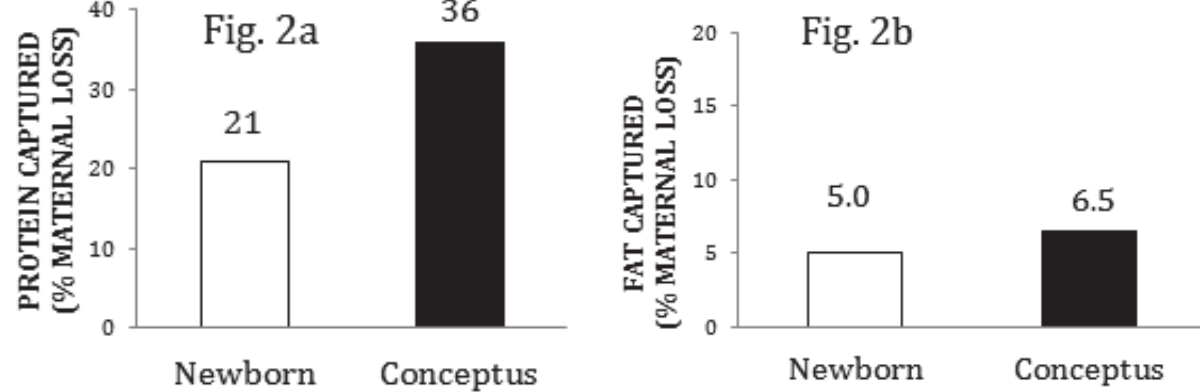
Fig. 2. Percent capture of protein (a) and fat (b) by the newborn fetus and conceptus of caribou of the Porcupine Herd based on the overwinter changes in body composition (Gerhart et al., 1996). Note the differences in scales for protein and fat.